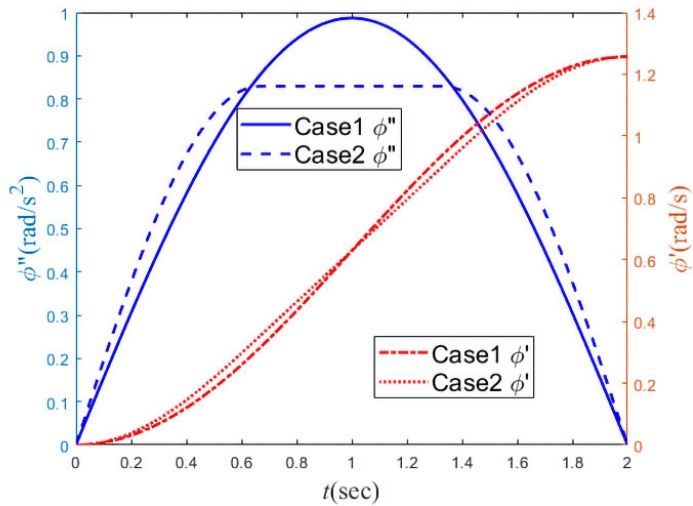
Figure 10. The dynamic rolling schemes.